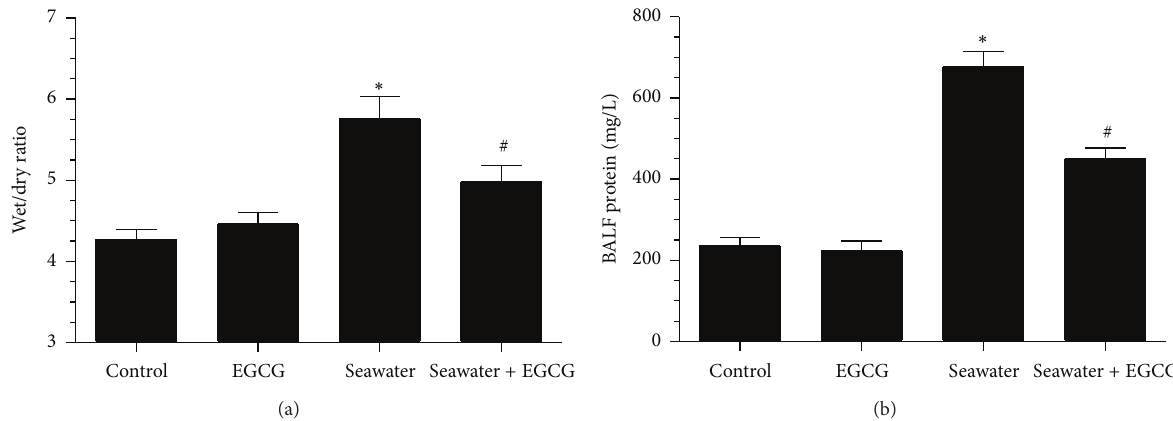
Figure 3: Effect of EGCG pretreatment on the lung edema (a) and the concentrations of total protein in BALF (b). EGCG significantly decreased lung wet/dry ratios and total protein in BALF in seawater aspiration-induced ALI rats. Data were presented as mean ± SEM ( 𝑛 = 12 for lung wet/dry ratios and 𝑛 = 6 for total protein in BALF). ∗ 𝑃 < 0.05 versus control group; # 𝑃 < 0.05 versus seawater